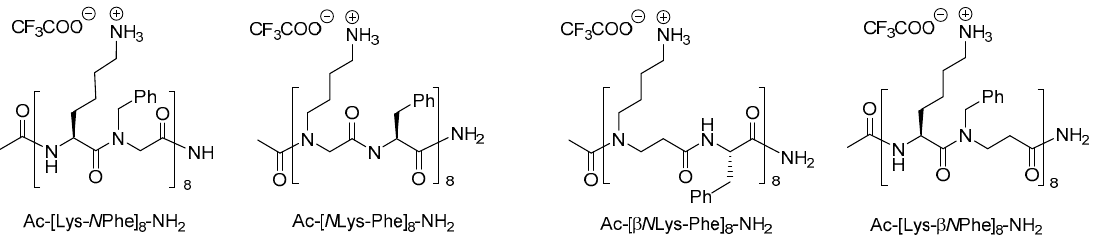
Figure 11. Oligomers assembled by MW-assisted monomer-based SPS [211].